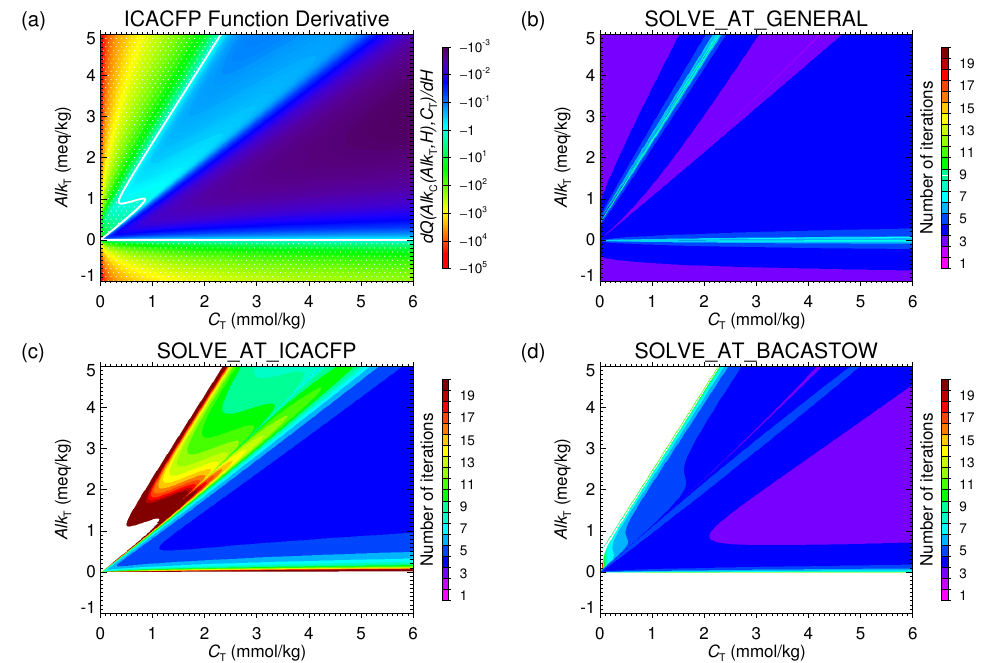
Fig. 3. (a) Derivative with respect to H of the function underlying the ICAC methods, i.e. of the function Q given by Eqs. (9) and (10) that defines the recurrence H n + 1 = Q( Alk C ( Alk T ,H n ),C T ) . The white line indicates where the derivative is equal to − 1; in the stippled area, the derivative is strictly lower than − 1. Also shown are the numbers of iterations required to meet the convergence criterion for (b) general , (c) icacfp and (d) bacastow with secant iterations on [H + ]. White areas indicate no convergence or an excessive number of iterations ( n >